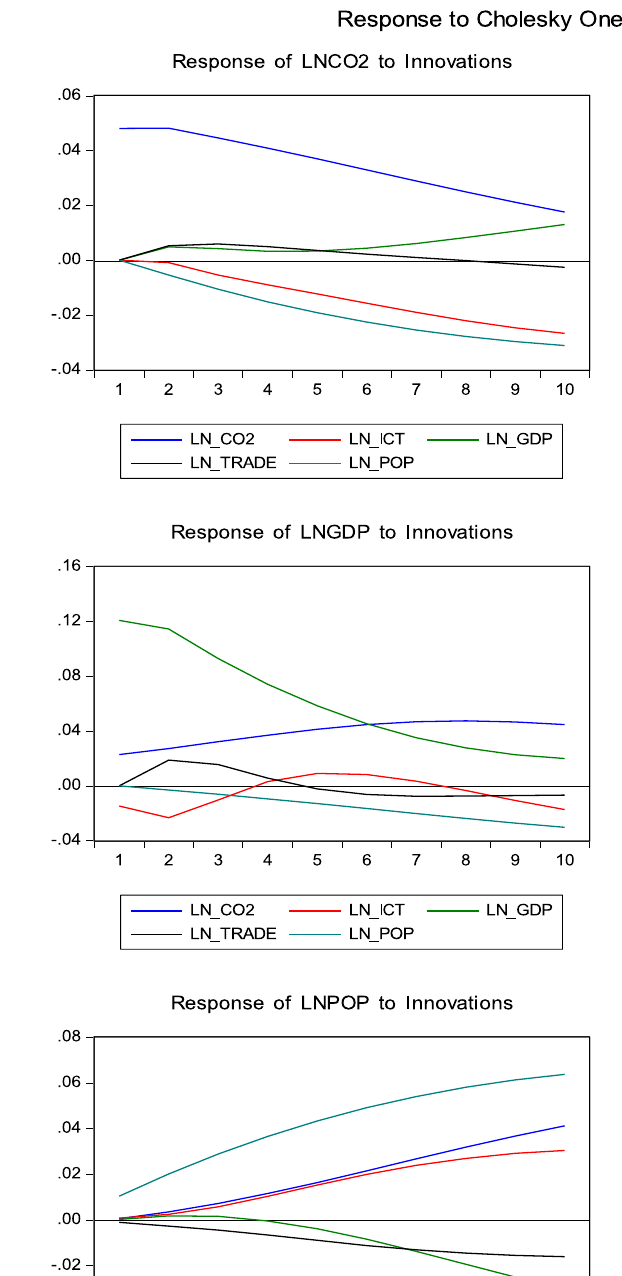
con fi rmed the reduction in CO 2 emission concerning variability in the rest of the variables. The impulse response is used to measure the impact of one standard deviation shock on an